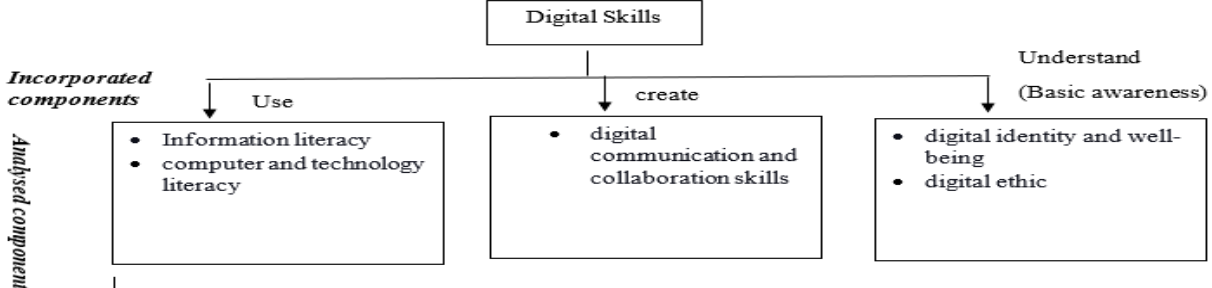
Figure 2. Comparison between the analyzed components (this study) and incorporated components [11]. nents